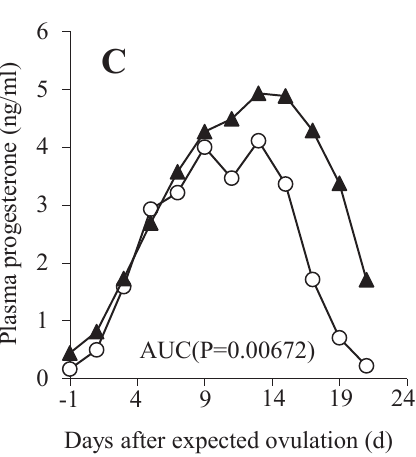
Figure 5. Effect of Se yeast supplementation on the plasma P4 concentrations (ng/ mL) of all CL that formed during the first 100 postpartum days (A), CL that developed after the third ovulation with estrus (B), CL that developed after ovulation with estrus between 60 to 80 days after calving (C). Blood sampling from the jugular vein was carried out in the morning every two days. Plasma P4 concentrations were measured using an enzyme immunoassay kit after diethylether extraction. All assays were performed in duplicate. Data are presented as mean±standard error of the mean values (-Se: n = 43, +Se: n = 45) in A, (-Se: n = 11, +Se: n = 11) in B, (-Se: n = 8, +Se: n = 12) in C. Significance was defined as a p value of